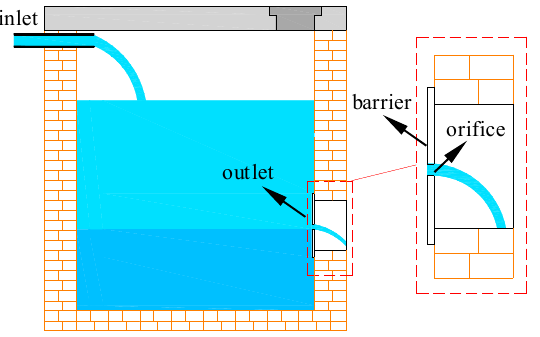
Figure 2. A schematic for a rainwater buffer tank.